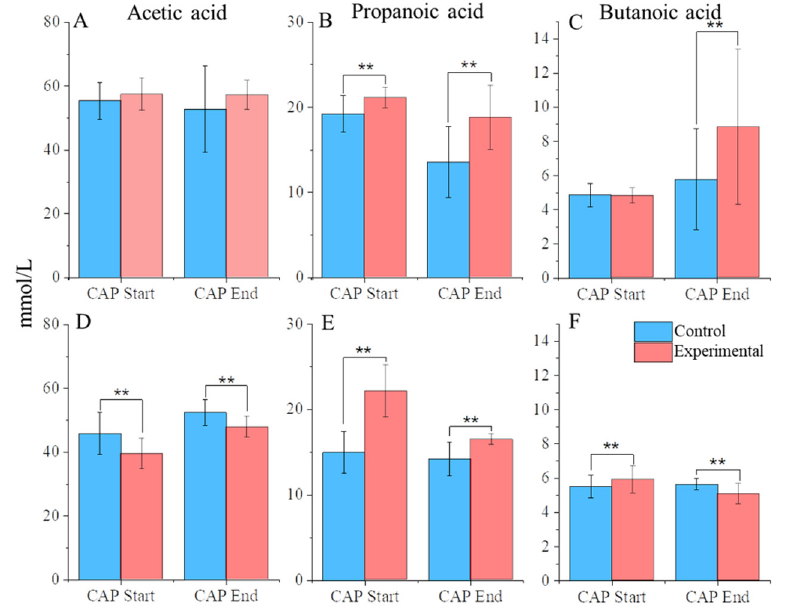
Figure 4. SCFA abundance. ( A ) C1 acetic acid, ( B ) C1 propanoic acid, ( C ) C1 butanoic acid, ( D ) C2 acetic acid, ( E ) C2 propanoic acid, ( F ) and C2 butanoic acid. ** = p < 0.01.